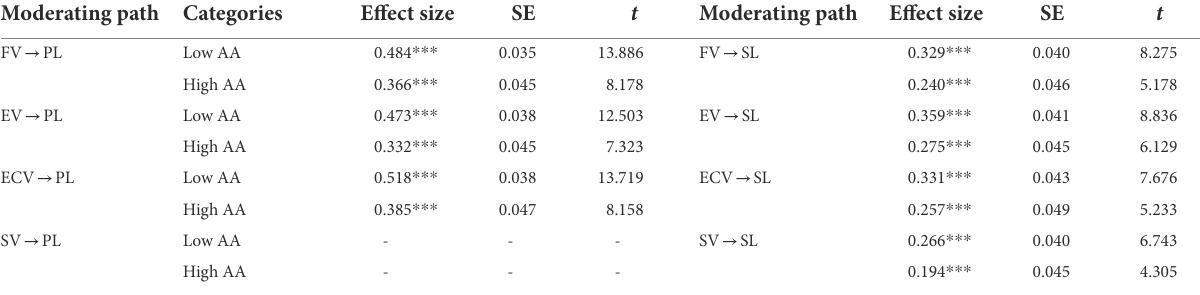
TABLE 11 The simple slope test for the moderation